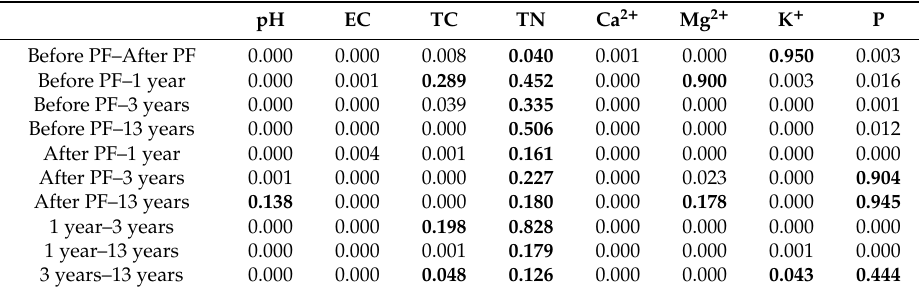
Table 2. One-way ANOVA p values. Significant di ff erences in bold. ( p < 0.005; n = 42). pH EC TC TN Ca 2 + Mg 2 + K + Before PF–After